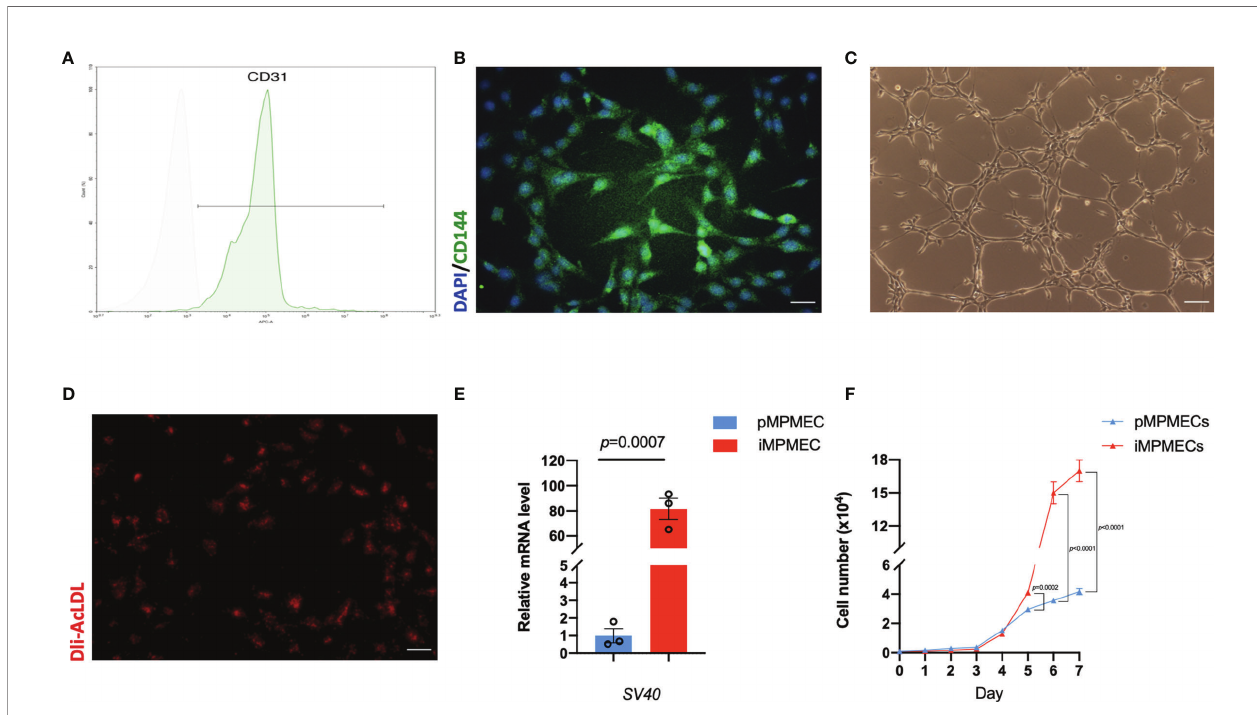
FIGURE 5 | Representative phenotypic and functional analysis of immortalized mouse pulmonary microvascular endothelial cells (iMPMECs). (A) Flow cytometry analysis of iMPMECs. Over 97% cells are CD31-positive. (B) iMPMECs also express CD144 (green) counterstained with DAPI (blue). Scale bar, 100 m m. (C) iMPMECs can form an endothelial network on Matrigel. Scale bar, 100 m m. (D) iMPMECs can also uptake Dil-AcLDL (red) in co-cultures with it for 12 h Scale bar, 100 m m. (E) The SV40 mRNA expression of iMPMECs is measured by real-time PCR, n = 3. p -value is determined by Student ’ s t -test. (F) The cell proliferation rate of iMPMECs and primary mouse pulmonary microvascular endothelial cell is measured by cell counts, n = 6. p -values are determined by Student ’ s t